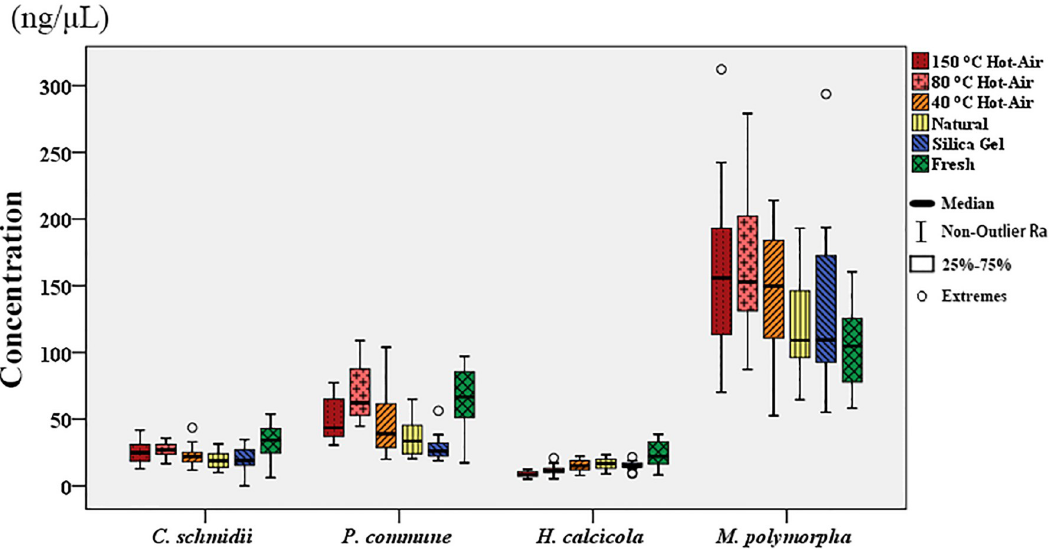
Fig 2. The concentration of extracted total DNA after different drying methods was detected by a microspectrophotometer.